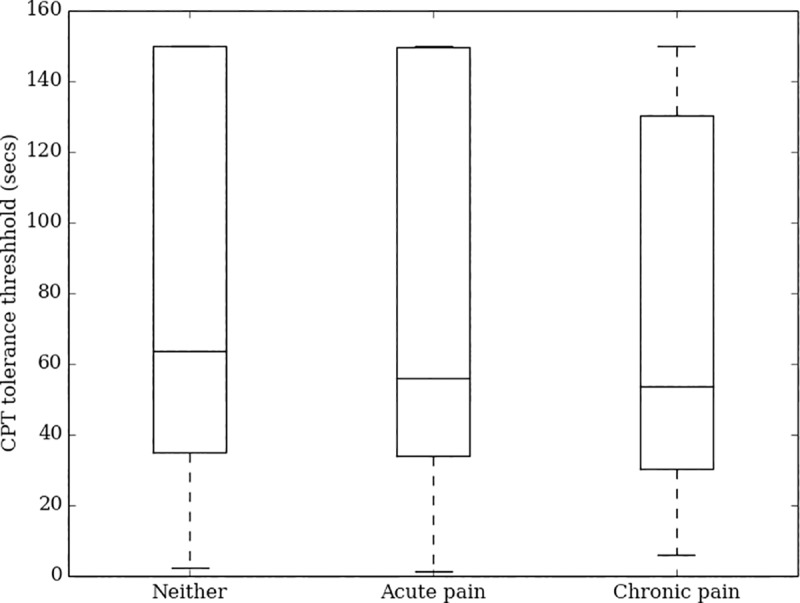
Box plot of CPT tolerance times by current pain status.